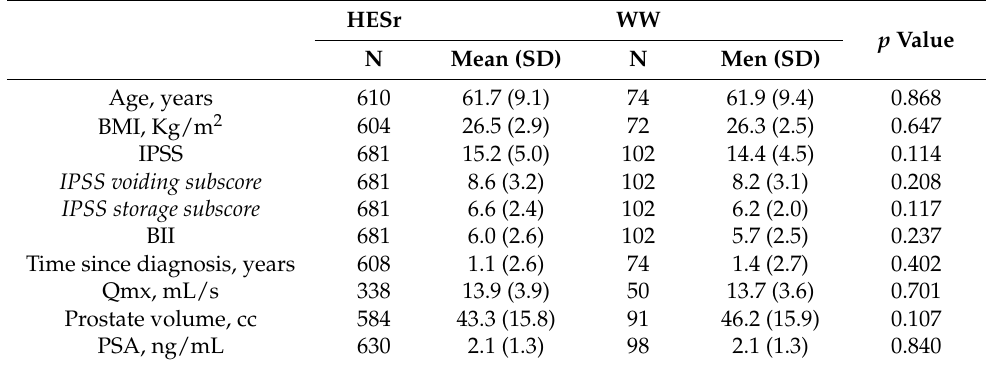
Figure 1. Study flow-chart (iterative matching sample). HESr: hexanic extract of Serenoa repens ; WW: watchful waiting. Table 1. Patient baseline characteristics by study group (iterative matching sample).